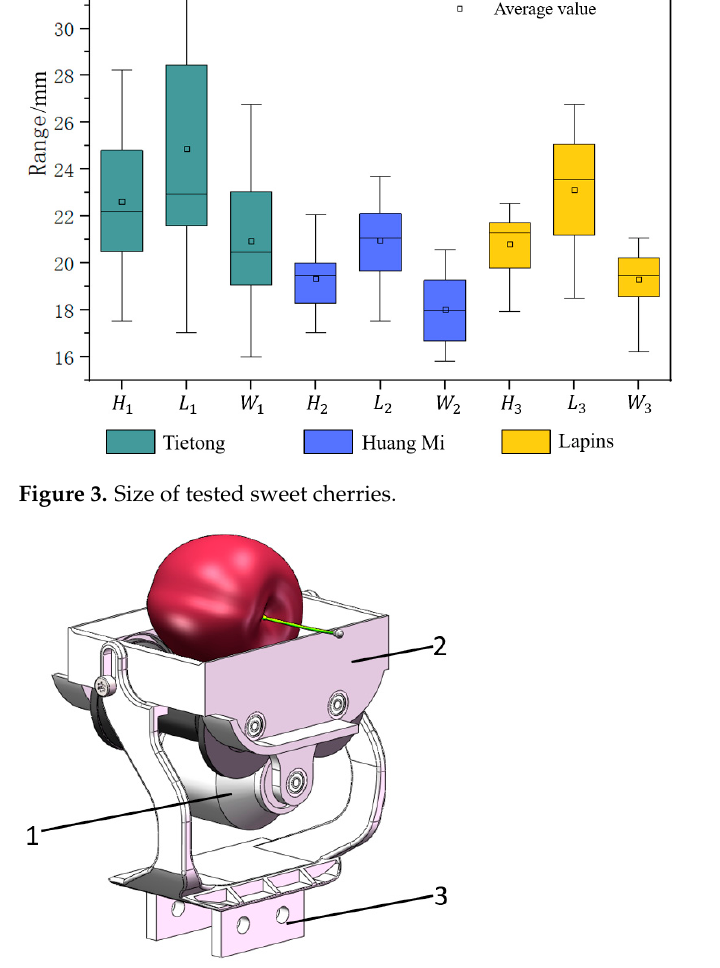
Figure 3. Size of tested sweet cherries.